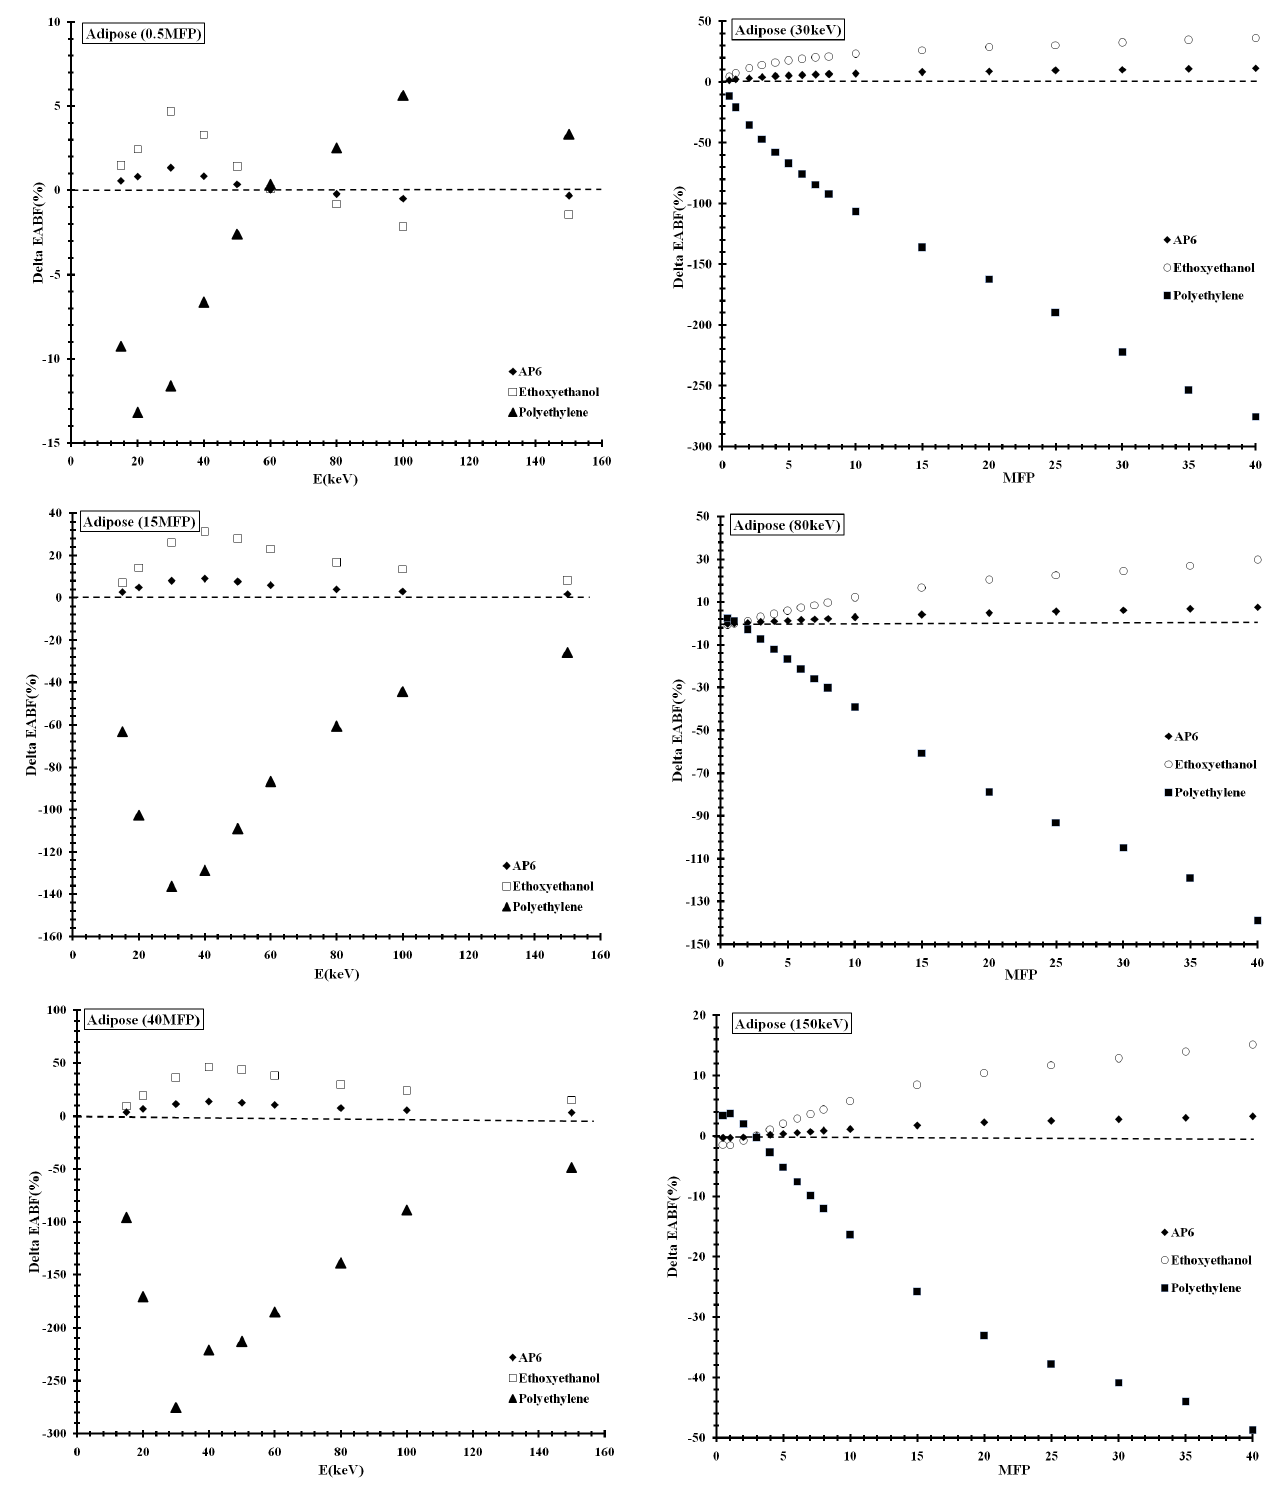
Figure 3. Relative deviation of energy absorption buildup factor of substitute materials to adipose tissue as a function of: ( left side) photon energy for fixed depths of 0.5, 15 and 40 mfp and ( right side) depth for fixed photon energy of 30, 80 and 150